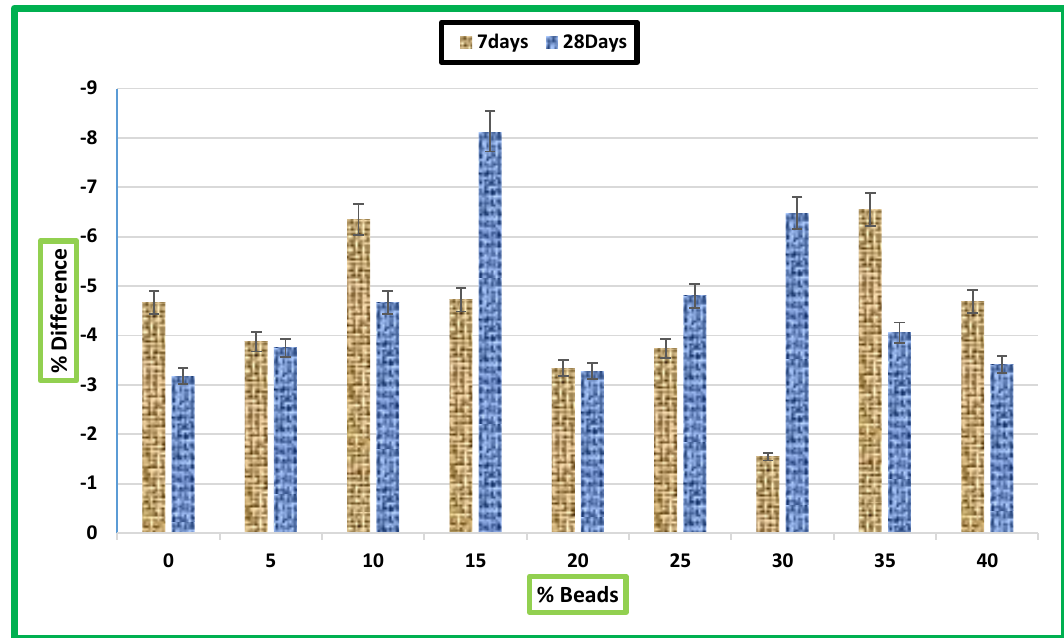
Figure 18. Strength difference vs. percentage beads replacement.